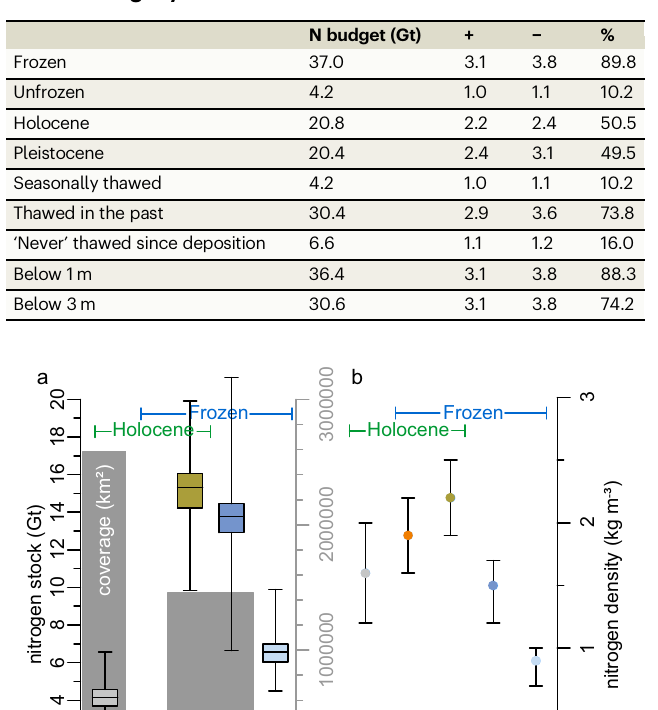
number of samples. For calculating C:N ratios, total N values <0.05 were excluded to avoid calculation artefacts due to measurement uncertainties. For visualisation of the NO 3 − density of Yedoma, we use a broken scale to show the very high upper value (7.25). See Fig. 1 for the abbreviations of the stratigraphical